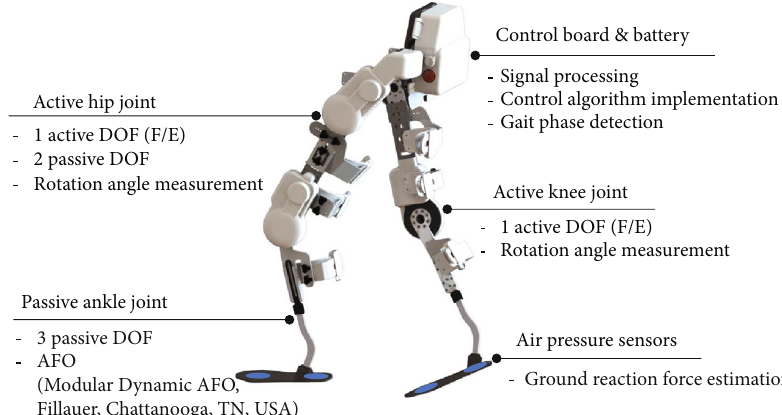
Figure 1: A robotic exoskeleton for lower limb assistance. DOF: degree of freedom; AFO: ankle-foot orthosis; F/E: fl